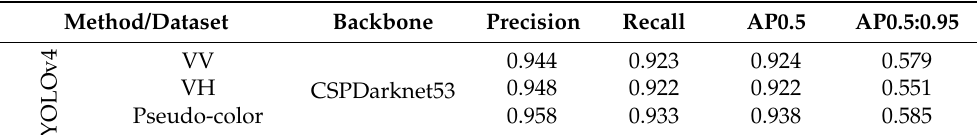
Table 3. YOLOv4 detection results on pseudo-color enhanced and the corresponding VV and VH polarized test set of DSSDD.